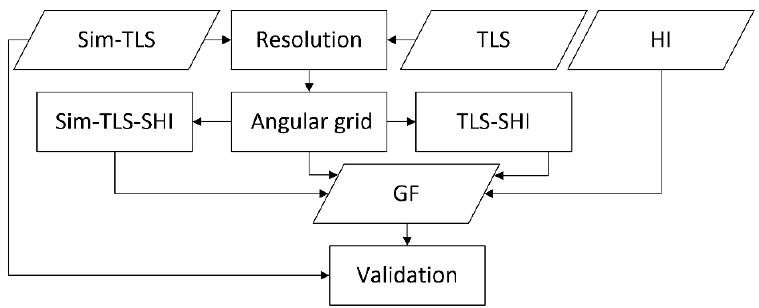
Figure 1. Flow chart of the methodology applied to carry out this research.